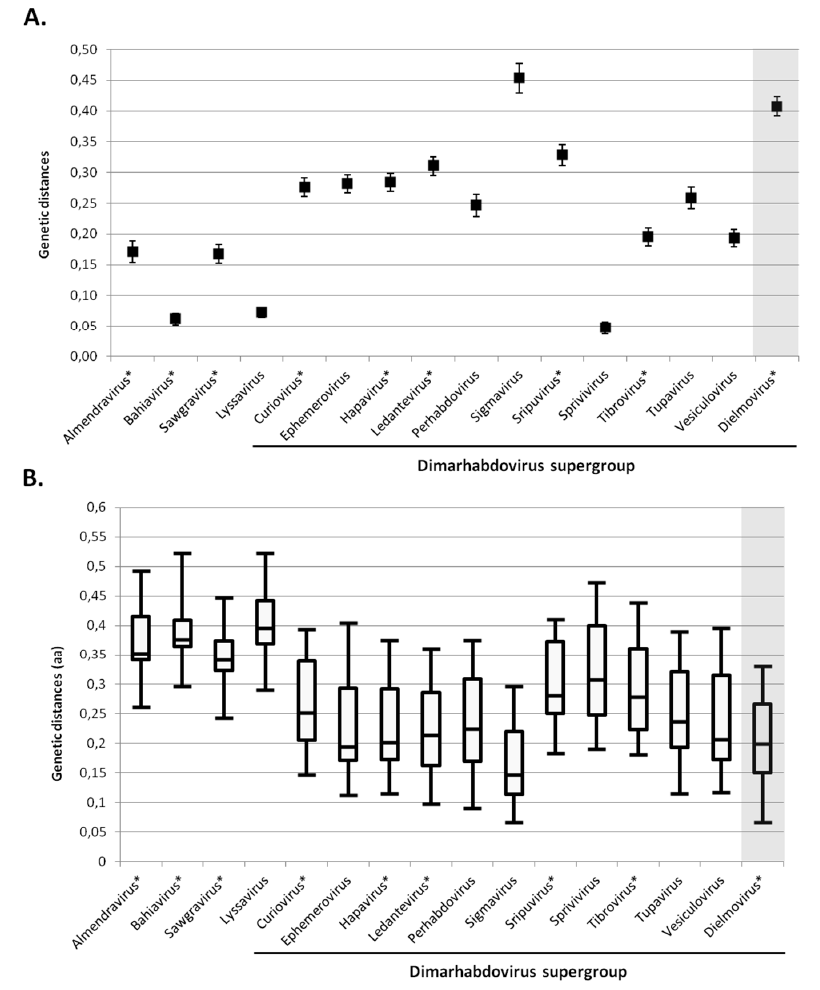
Figure 6. Genetic distances of Dielmovirus genus compared to other Rhabdoviridae . ( A ) Mean distances within recognised and putative Rhabdoviridae genera (putative genera, as reported in [27], are indicated by a *). Diversity was calculated by the pairwise ‐ distance algorithm implemented through MEGA6 [23], and 1000 bootstrap replications; ( B ) Distribution of distances between recognised and putative Rhabdoviridae genera (putative genera are indicated by a *). Diversity was calculated by the pairwise ‐ distance algorithm implemented through MEGA6 [23]